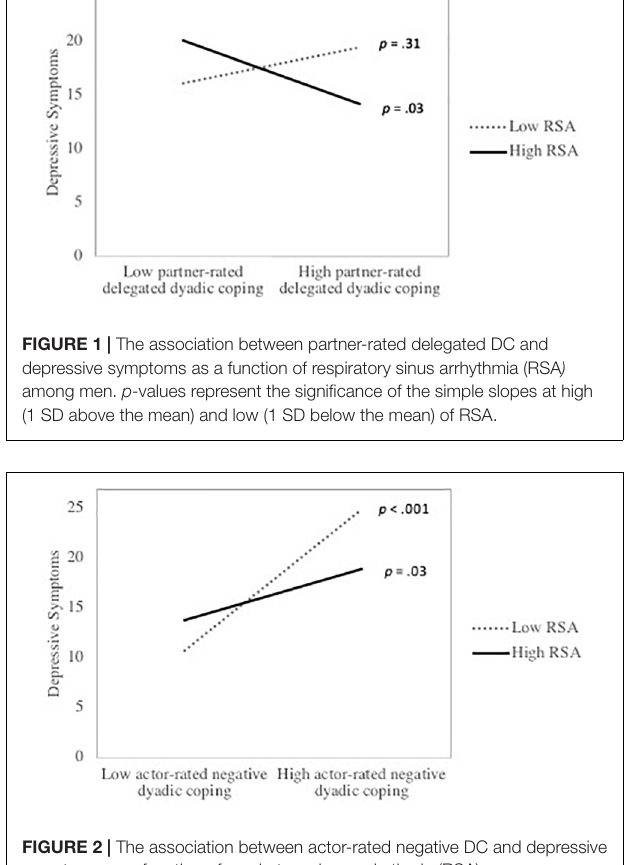
FIGURE 2 | The association between actor-rated negative DC and depressive symptoms as a function of respiratory sinus arrhythmia (RSA) among men. p values represent the significance of the simple slopes at high (1 SD above the mean) and low (1 SD below the mean) of